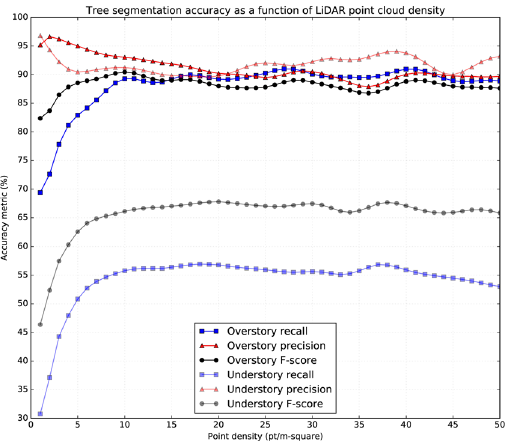
Figure 4. Accuracy scores of tree segmentation based on density of LiDAR point cloud for overstory and understory trees. Each symbol in the diagrams represents average across 23 sample plots from Robinson